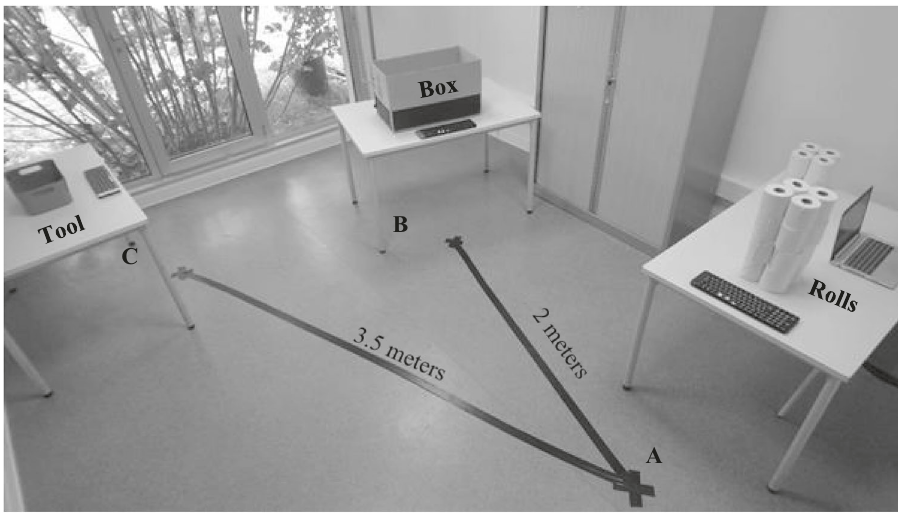
Fig. 3 Experimental set up. The rolls were placed on table A, the box on table B, and the tool (i.e., the bowl) on table C. A Bluetooth keyboard was placed on each table. The distances were drawn on the fl oor, the distance AB was 2 m and the distance AC was 3.5